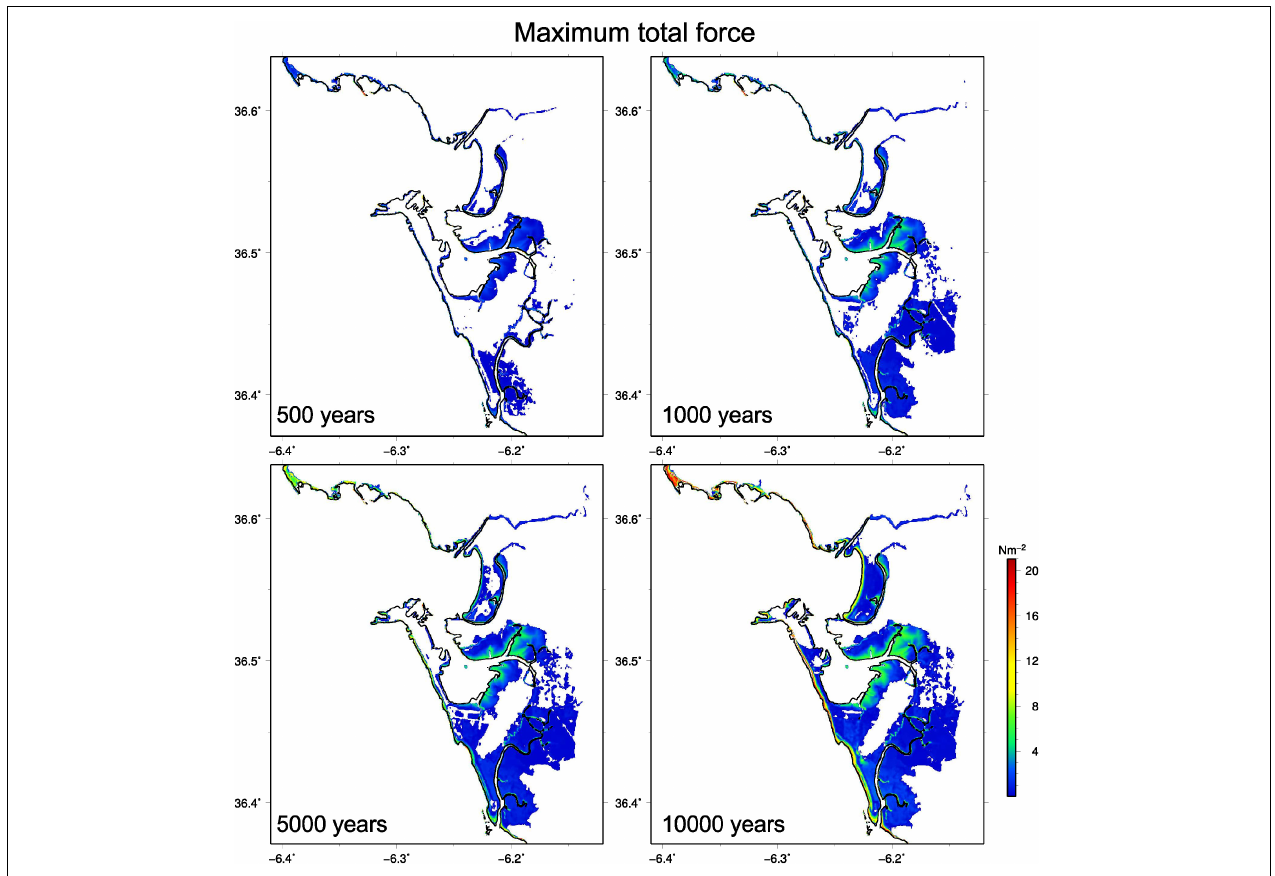
FIGURE 12 | Maximum forces for different return periods, per unit area of exposed element. 99% confidence